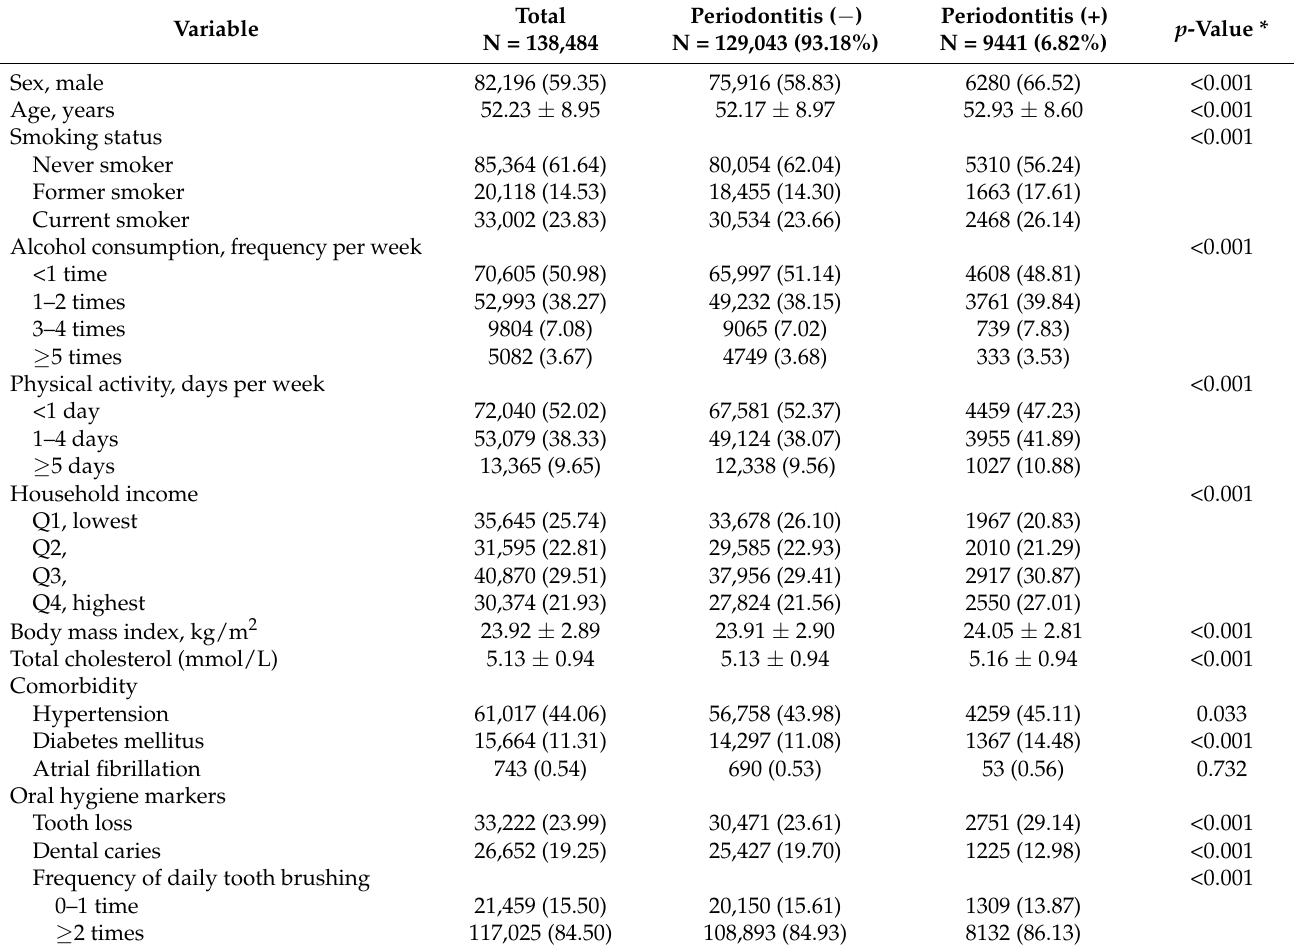
Table 1. Baseline characteristics of the study